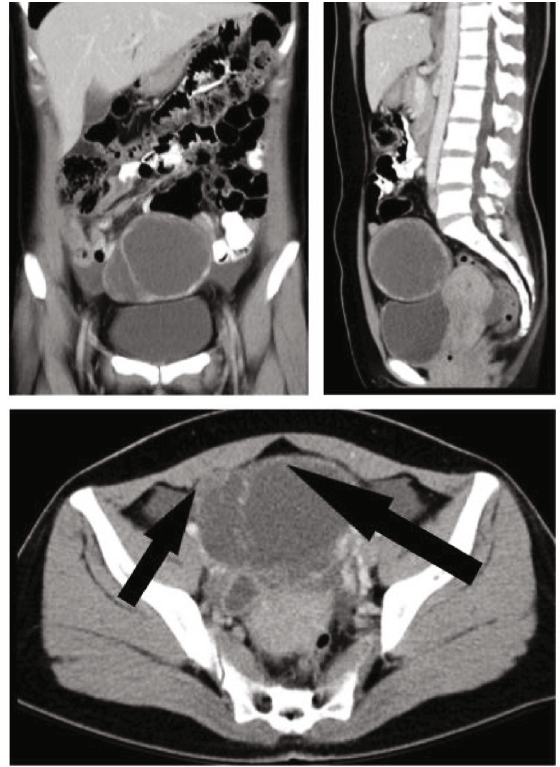
Figure 1: CT scan abdomen/pelvis shows a left adnexal, complex cystic lesion with enhancing, solid nodules along its wall (black arrows), likely arising from the left ovary.